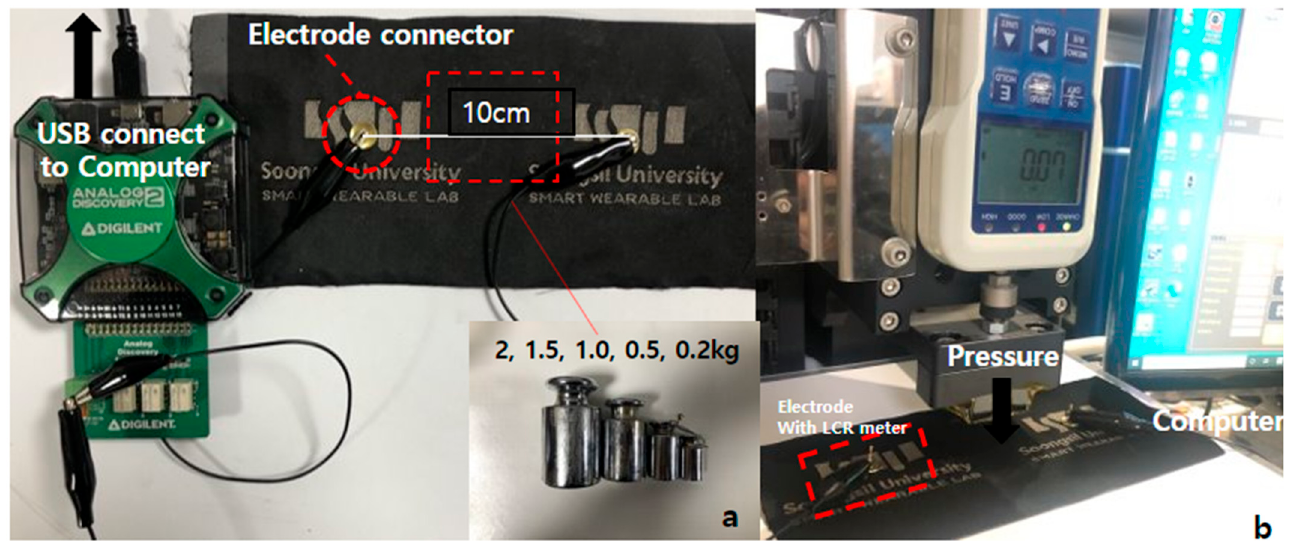
Figure 7. Measurement setup for a proposed pressure sensor, ( a ) loads, ( b )